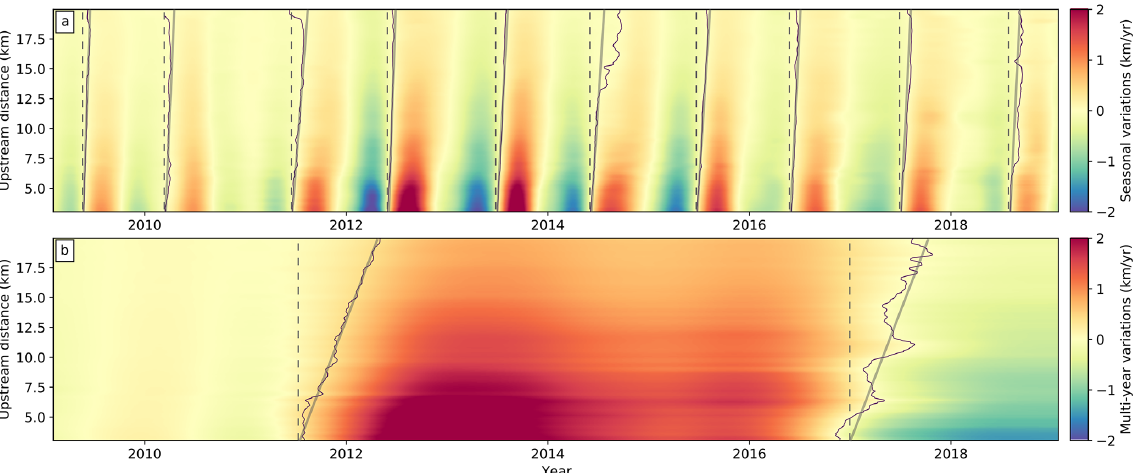
Figure 2. Temporal evolution of glacier flow variations along a centerline segment for decomposed seasonal (a) and multi-year (b) signals. The centerline trace is shown in map view in Fig. 4, and distance values here are measured upstream along the centerline from the winter 2017 terminus position. Thin black lines correspond to contours of zero-velocity variation at the initiation of each signal – summer speedups for (a) and 2012 speedup and 2017 slowdown for (b) . Solid gray lines approximately follow the zero-velocity contours and indicate the leading edges of propagating velocity variations. Vertical dashed gray lines indicate onset times for the propagating wave initiating at the terminus and are equivalent to the propagation path for a wave with infinite propagation speed. The tangent of the angle between solid and dashed gray lines is the phase velocity averaged over the observable propagation distance. The marked difference in phase velocities between the seasonal and multi-year signals indicates (frequency)